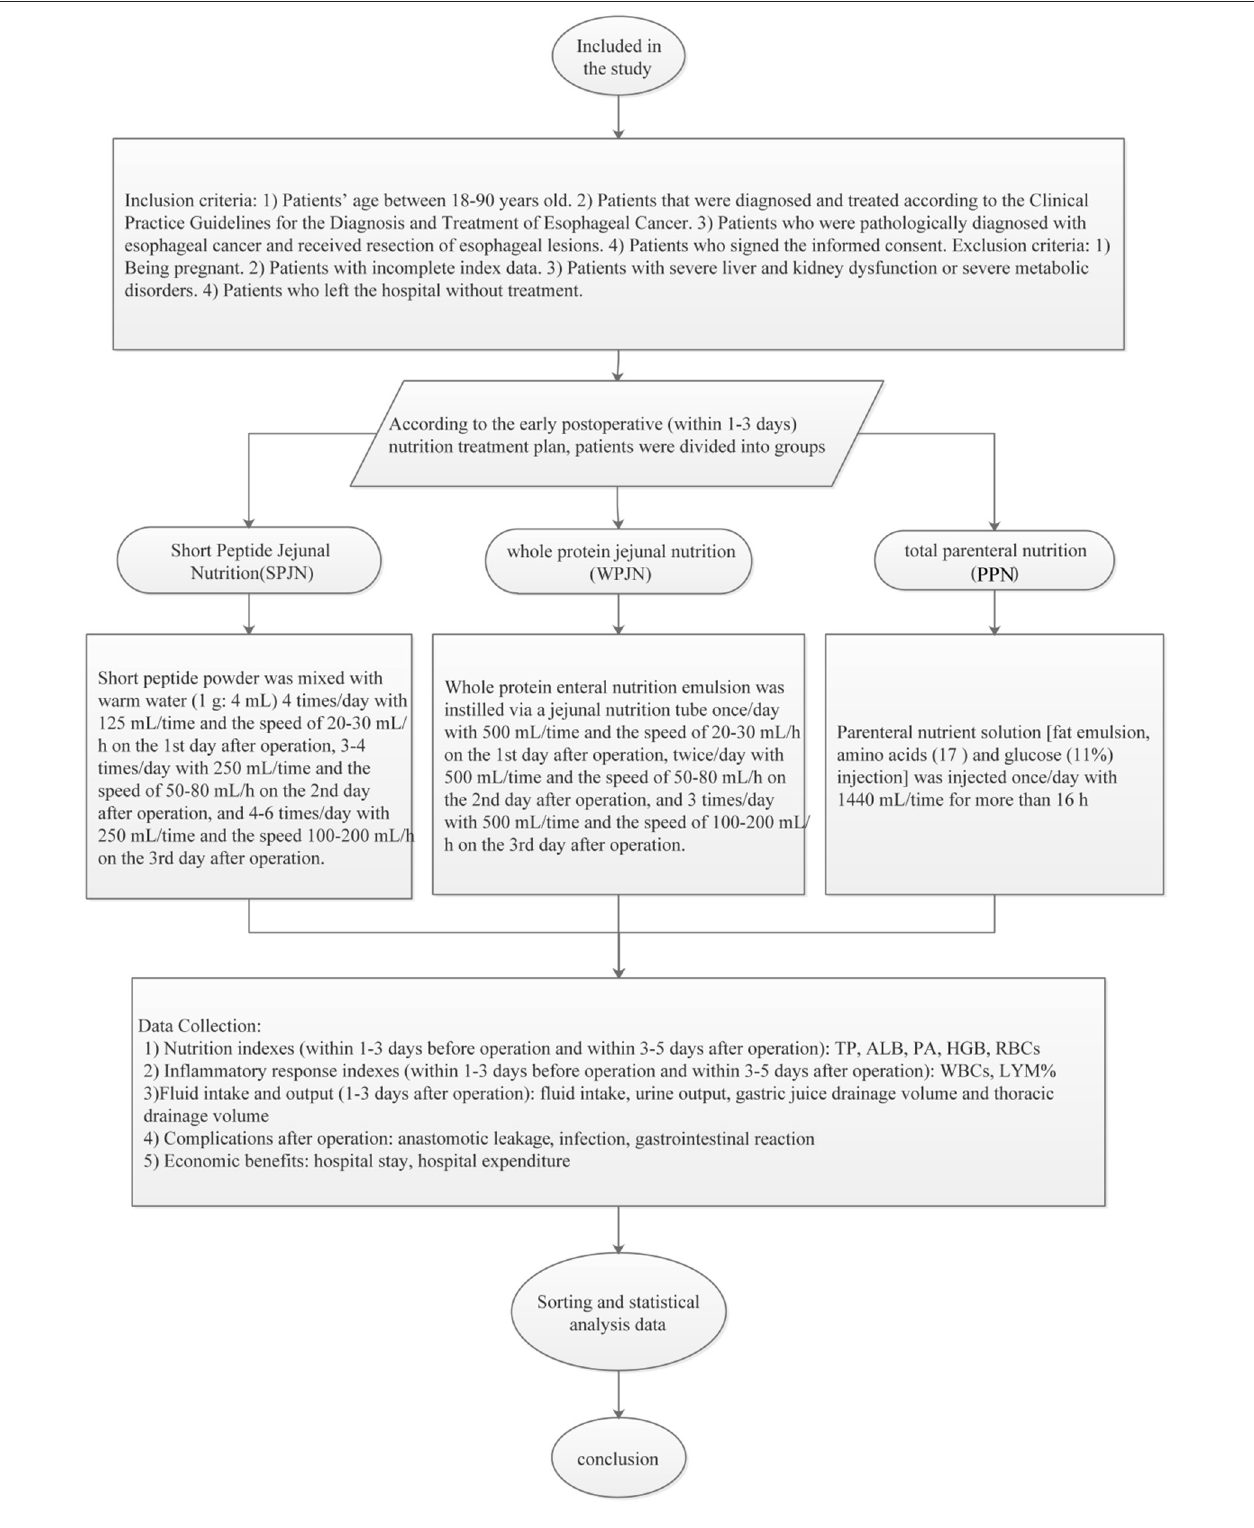
FIGURE 1 | Research technology roadmap. Eligible patients were screened out using the Comprehensive Data Retrieval of Medical Care in the hospital electronic medical record system. They were divided into SPJN group, WPJN group and PPN group according to the nutritional therapy scheme in the early post-operative period (within 1–3 days). The differences in nutrition index, the inflammatory reaction index, fluid balance index, post-operative complications, cost-effectiveness and other indexes among the three groups were compared, and the transfer was analyzed and discussed. Patients benefit most from early post-operative nutrition therapy.